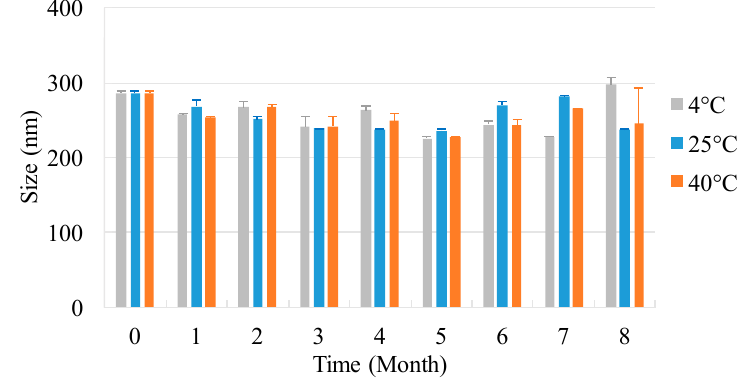
Figure 3. Stability of MDZ nanoparticles.